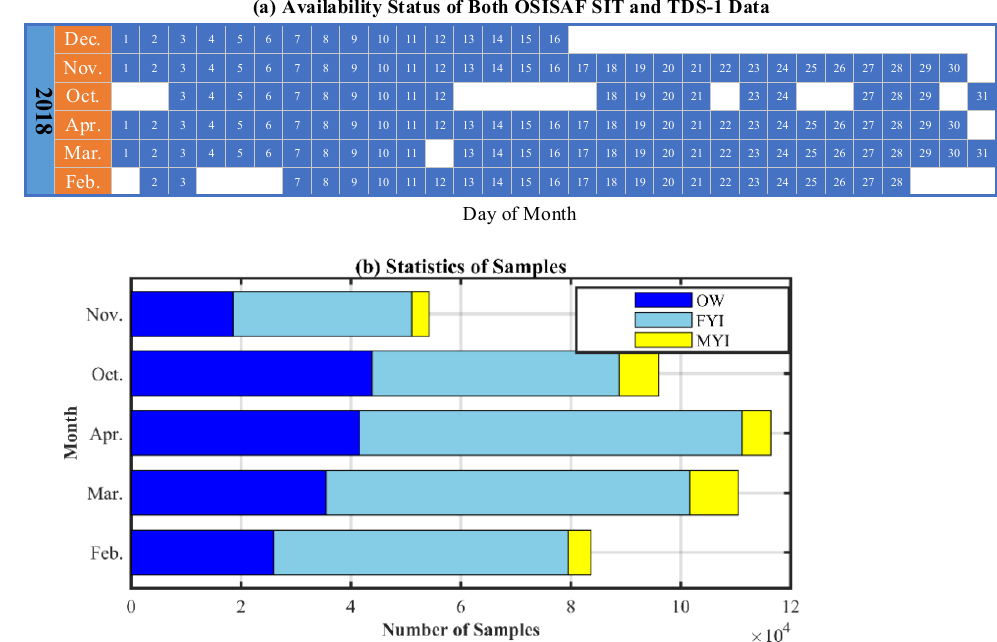
Figure 10. ( a ) The availability of both TDS-1 and OSISAF SIT data, which includes the information of open water (OW), first-year ice (FYI), and multi-year ice (MYI) in 2018. ( b ) Statistics of OW, FYI, and MYI samples every month.